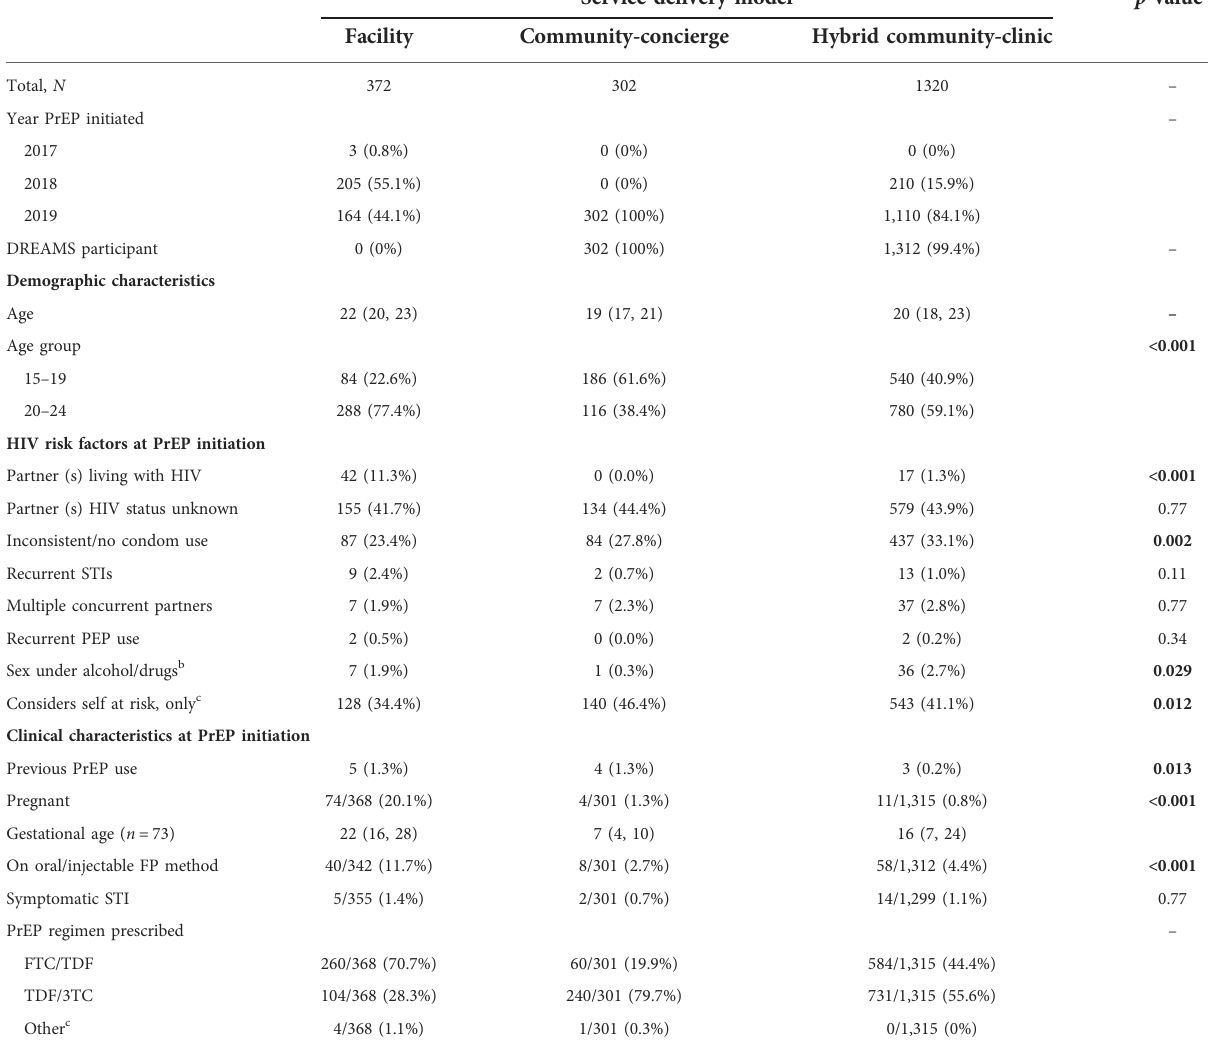
TABLE 1 Characteristics of adolescent girls and young women who initiated PrEP ( n =1994) by service delivery